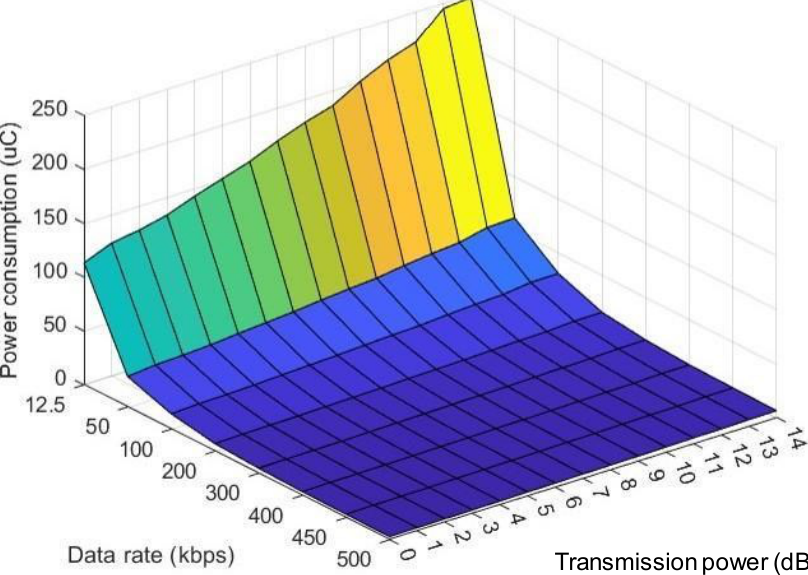
Figure 3. Relationship between power consumption, data rate, and transmission power.